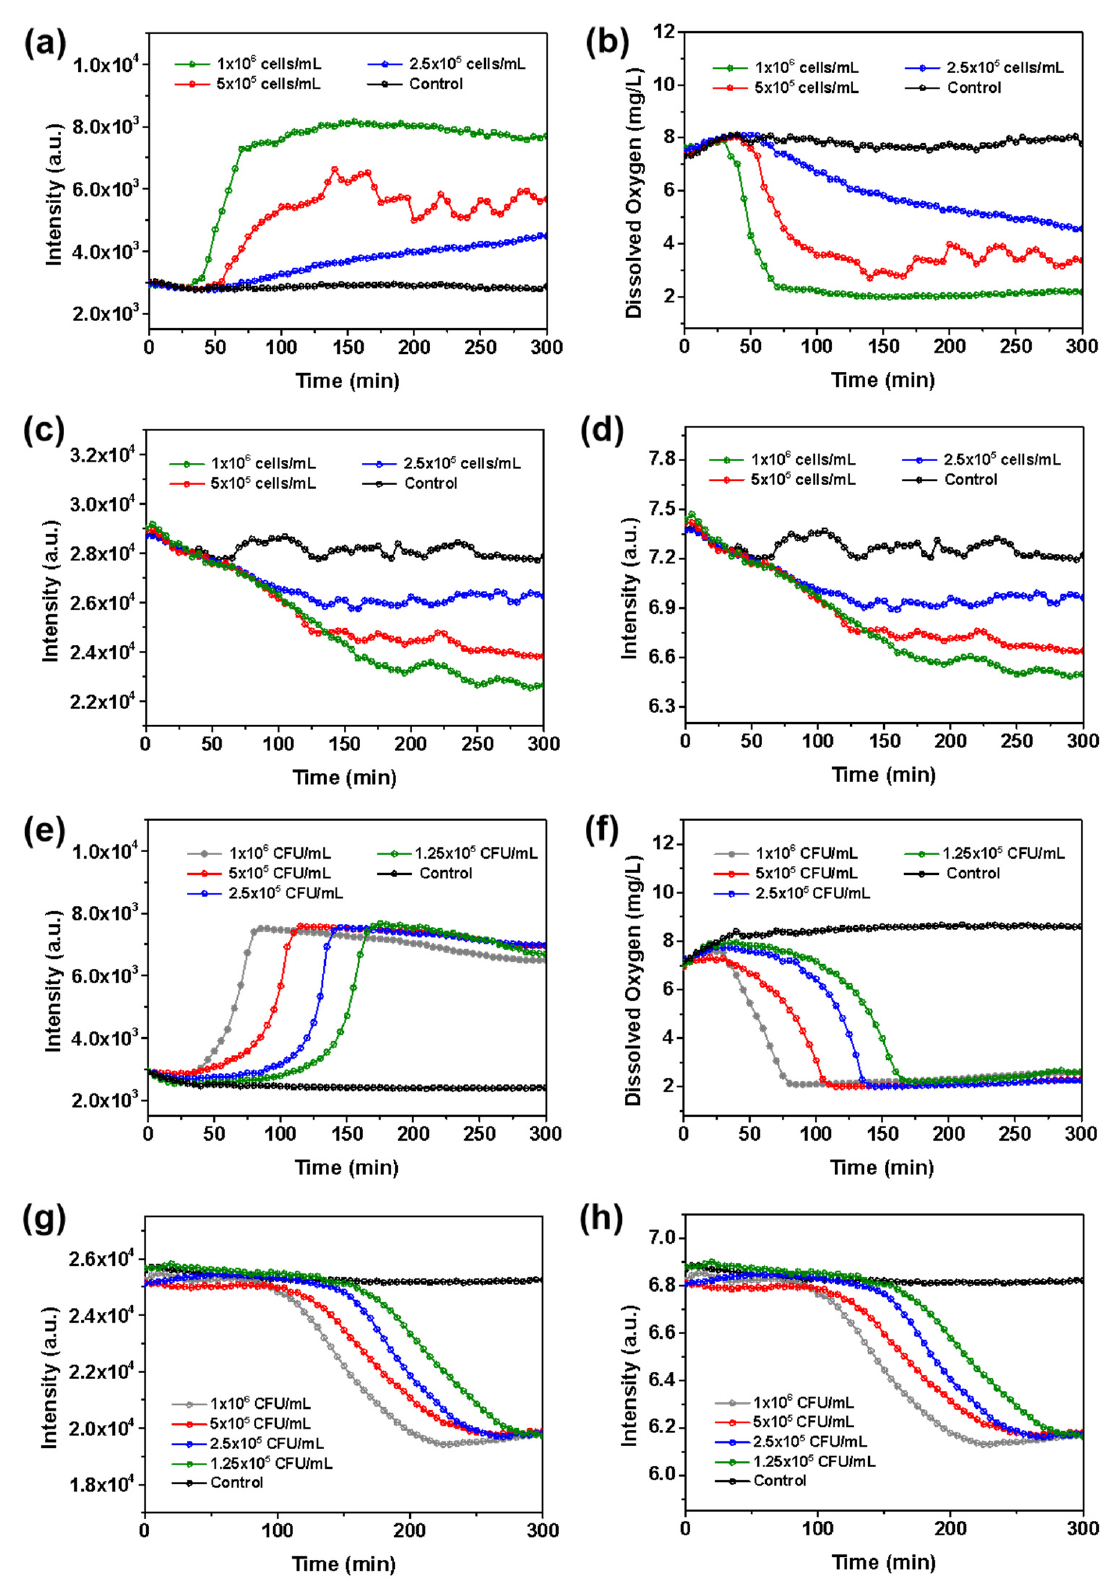
Figure 7. DO and pH monitoring of ( a – d ) NIH 3T3 cells and ( e , f ) E. coli. Luminescence intensity changes of ( a , e ) PtTFPP (DO, λ ex = 405 nm, λ em = 650 nm) and ( c , g ) CS-FITC (pH, λ ex =488 nm, λ em = 520 nm) during the growth of cells were monitored by F3; DO concentrations ( b , f ) and pH values ( d , h ) calculated from the calibration curves.